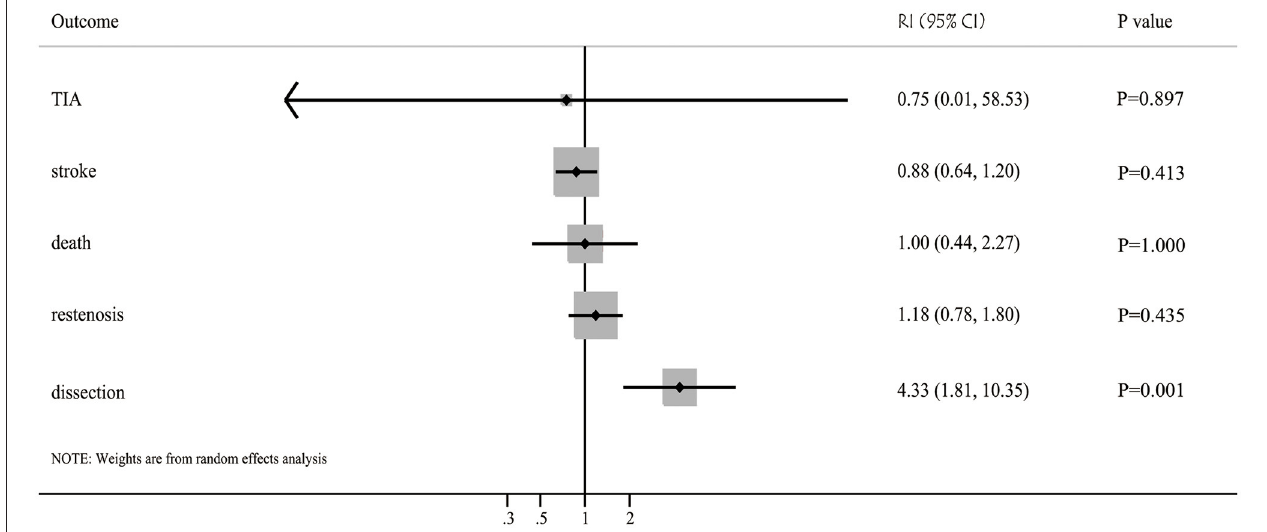
FIGURE 2 | Balloon angioplasty vs. stenting with regards to the risk of restenosis, TIA, stroke, death, and dissection for patients with symptomatic intracranial arterial stenosis.